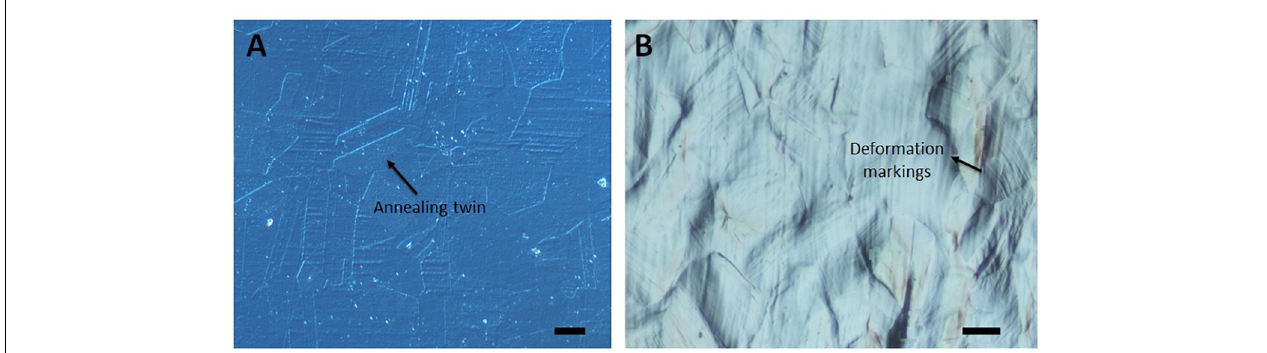
FIGURE 1 | Optical microscope DIC images of the (A) undeformed and (B) 25% deformed sample. Scale bars are 10 µ m. (Figure is more readable and visible on the screen rather than in print).